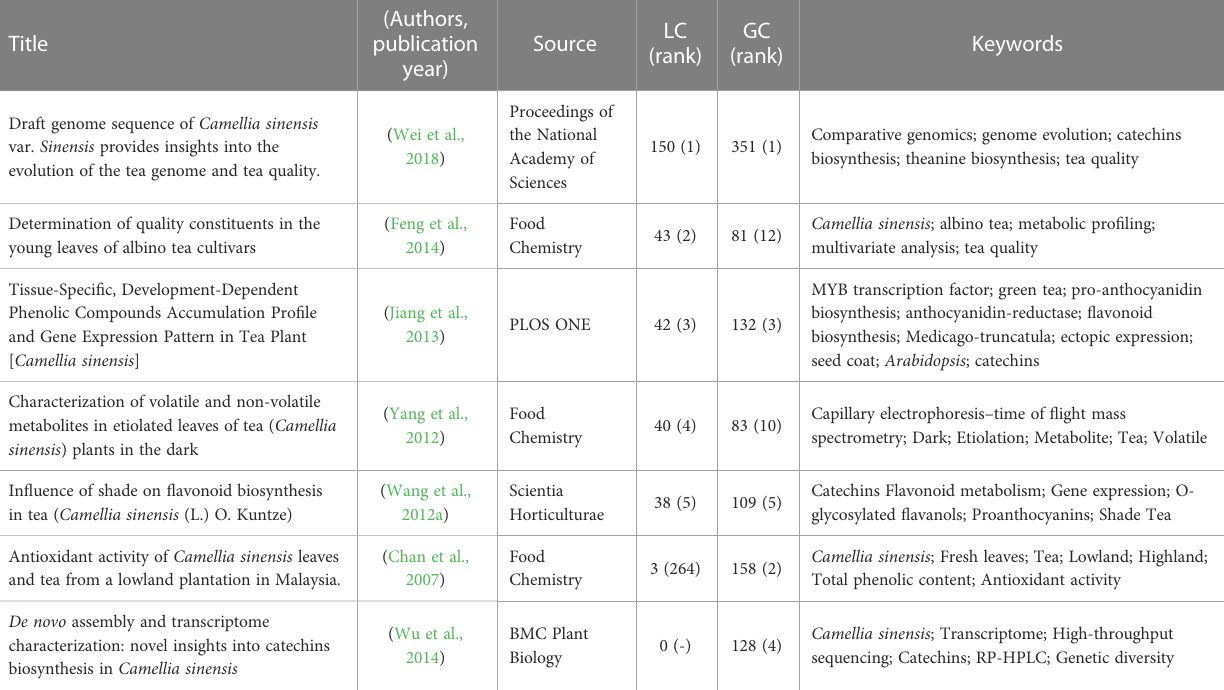
TABLE 3 Top fi ve most cited articles locally and